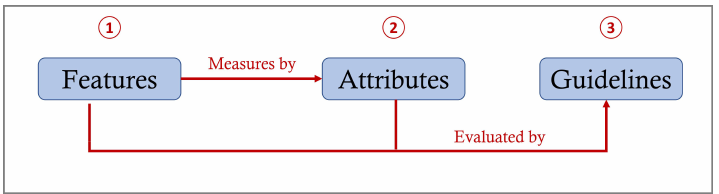
Figure 3. Matching process for features, attributes and